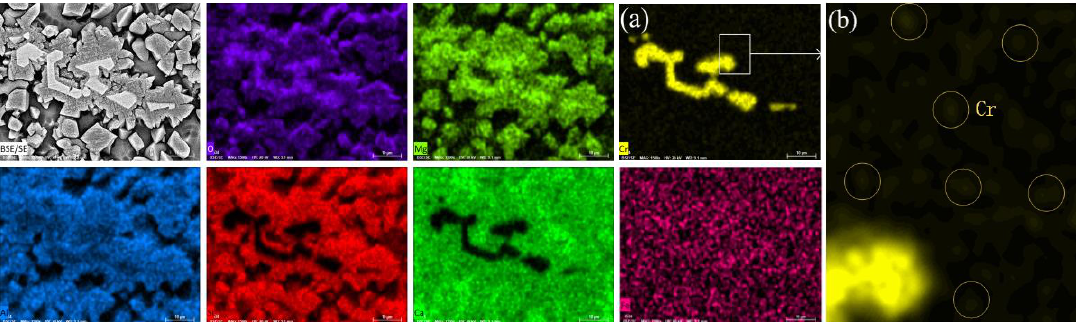
Figure 10. SEM image of the cross-section of glass – ceramics #3 and their X-ray mapping (( a ) is Cr element, ( b ) is an enlarged view of the part of ( a )). element, ( b ) is an enlarged view of the part of ( a )).